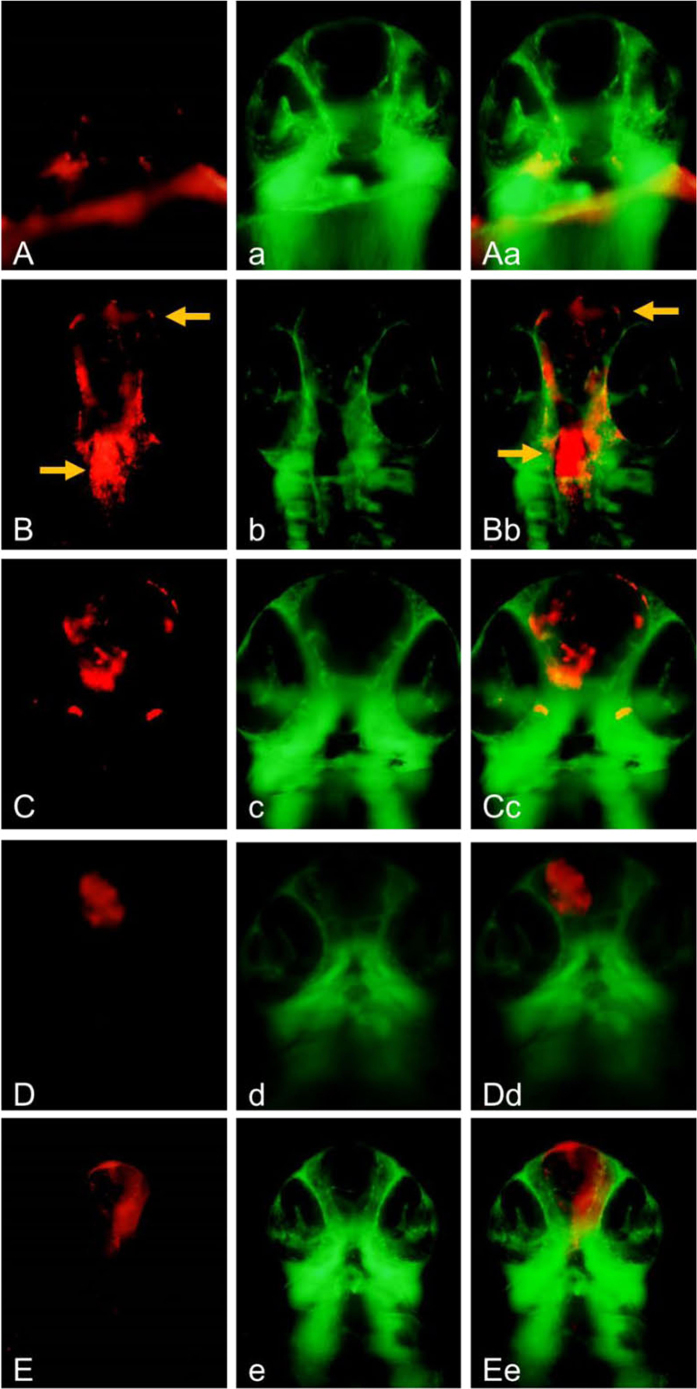
The protective effects of TS-15 and TS-40 against atorvastatin-induced cerebral hemorrhage in zebrafish.(A,a and Aa) the embryos treated with 0.2% DMSO served as the normal control group; (B,b and Bb; C,c and Cc; D,d and Dd; E,e and Ee) the embryos were pretreated with either 0.2% DMSO, Y27632 (10 mM), TS-15 (20 mM) or TS-40 (20 mM) for 2.0 hours and replaced with 1 mM atorvastatin for 24 hours. Homozygous double transgenic zebrafish, the red fluorescence was the Tg (gata1: dsRed) sd2 (A–E), the green fluorescence was Tg (fli1a: EGFP) y1 (a–e), and the third column was the overlapping photos of the first two columns (Aa, Bb, Cc, Dd and Ee). The arrows indicated the erythrocyte accumulation in cerebral hemorrhage region in zebrafish head.